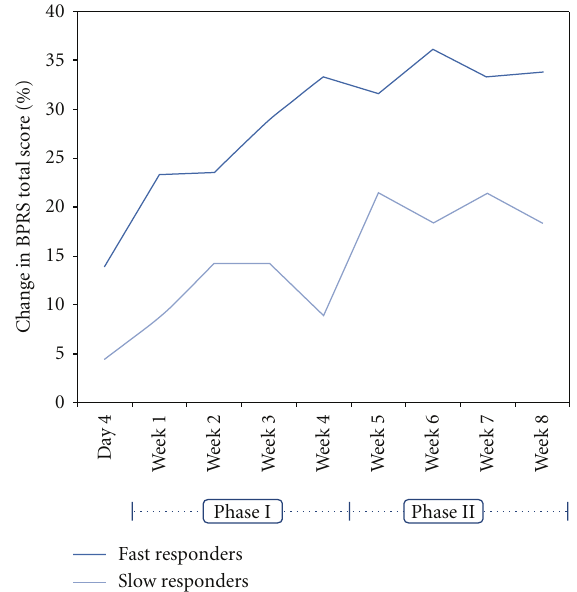
Figure 3: Percentage change in Brief Psychiatric Rating Scale (BPRS)total score from baseline for fast and slowresponders during phase I (weeks 1–4) and phase II (weeks 4–8) of the study.